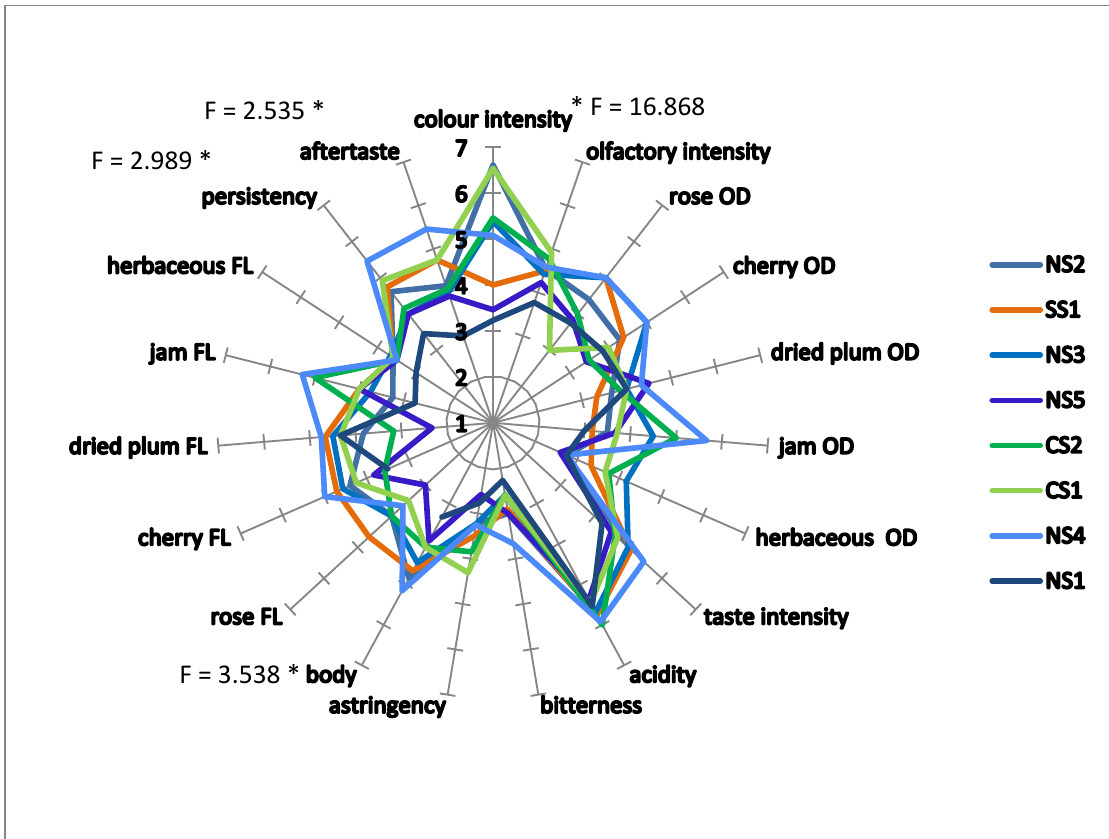
Figure 1. Graphical representation of the sensory profile of Cannonau wine samples. Values indicate the means for each attribute. The F values represent significant differences between the samples in relation to the individual attributes marked with the asterisk * ( p < 0.05). NS1-5 = north Sardinian wines; CS1-2 = central Sardinian wines; SS1 = south Sardinian wines. OD represents olfactory attributes, while sensory attributes followed by FL (flavor) represent flavor attributes.